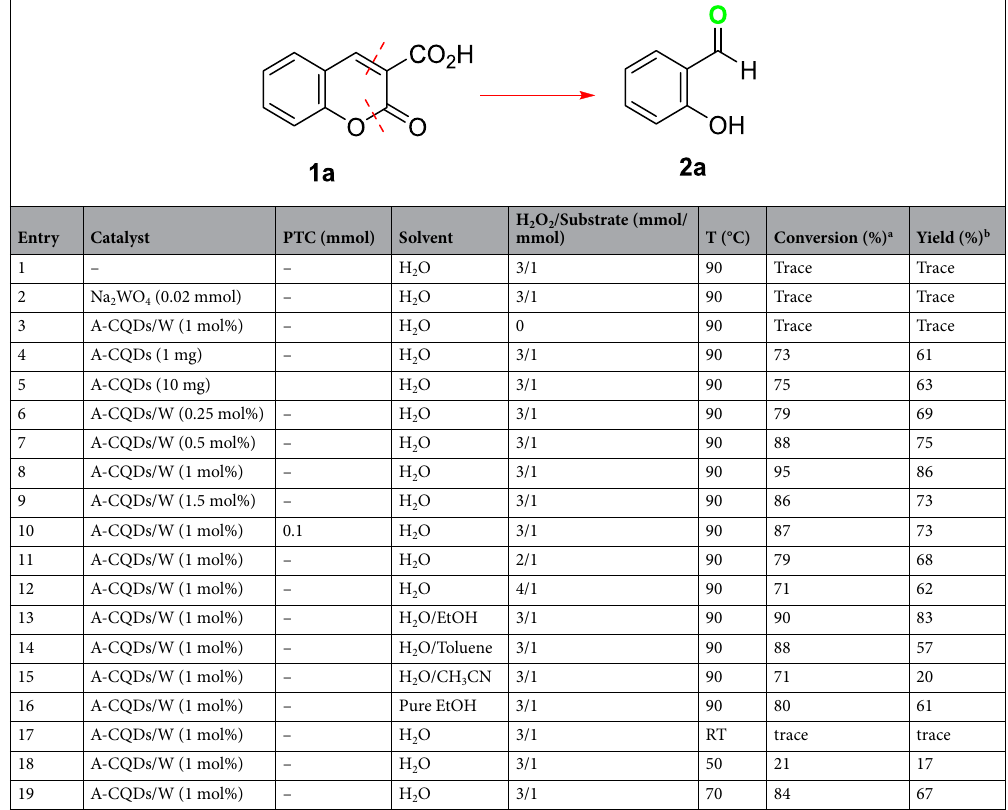
Table 1. The effects of various reaction conditions on the oxidative cleavage of coumarin-3-carboxylic acid with A-CQDs/W. Reaction conditions: Coumarin-3-carboxylic acid (1 mmol), H 2 O (1.5 mL), 90 °C, 3